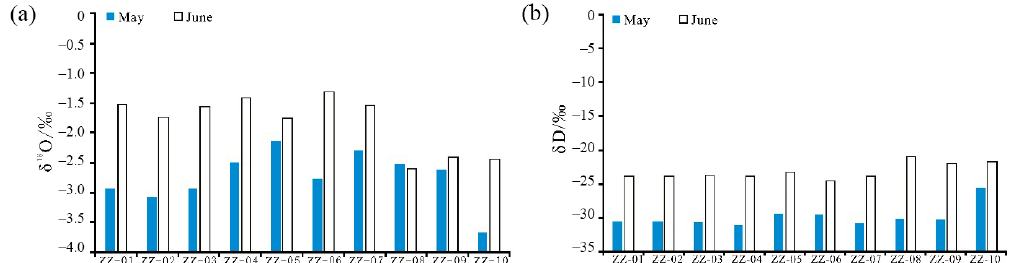
Figure 2. Changes in lake water δ 18 O and δ D